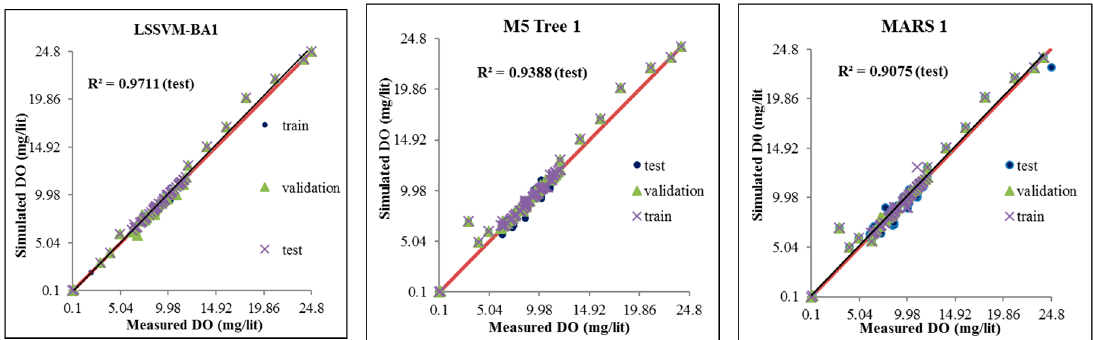
Figure 4. Scatter plot of observed and simulated DO concentration by three predictive models during model training, validation, and testing at USGS 14206950.